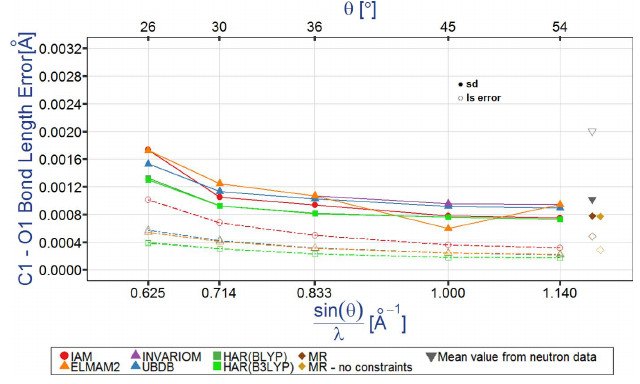
Figure 4 Typical dependencies of the errors of the geometrical parameters (in this case for the C1—O1 bond length) on data resolution and the electron density model refined against X-ray and neutron data; l.s. stands for the least-square e.s.d.